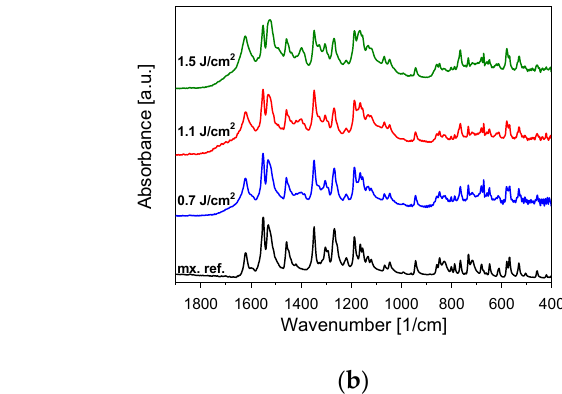
Figure 3. ( a ) Fingerprint part of the Fourier transform infrared (FTIR) spectra of pulsed laser ablation (PLA)-generated particles and the original meloxicam (mx. ref.) powder as reference. ( b ) Fingerprint part of the FTIR spectra of pulsed laser ablation in liquid (PLAL)-generated particles and the original meloxicam (mx. ref.) powder as reference. The FTIR spectra were normalized in both cases to the peak at around 1550 cm − 1 .